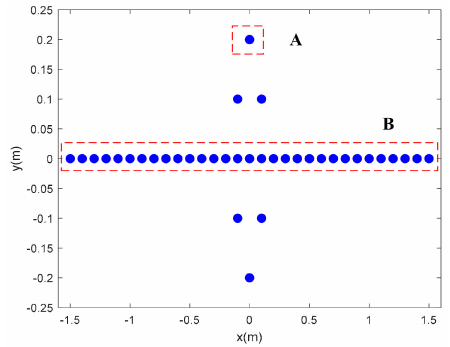
Figure 5. Target